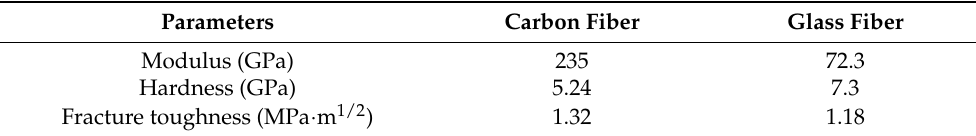
Table 4. Carbon fiber and glass fiber material property parameters